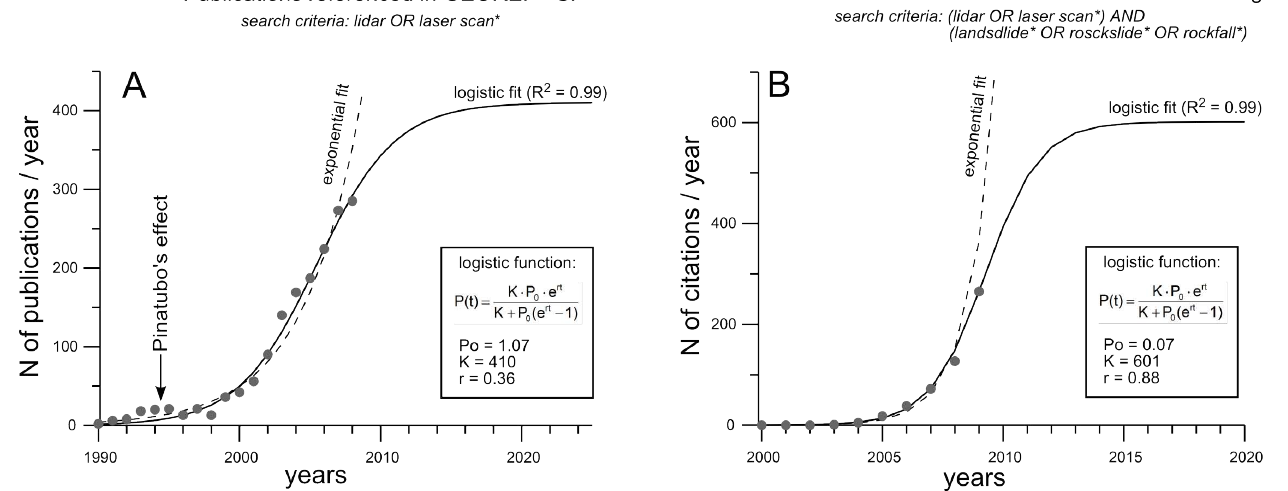
Fig. 1. (A) Number of publications per year (dots) registered in GEOREF that are related to LIDAR or laser scanning. The line is the best fit logistic function of the dots, with t =0 in 1990. The small increase of papers published in the mid 90’s is due to the use of LIDAR to study aerosols from the 1991 Pinatubo’s explosion. (B) Number of citations per year (dots) registered in ISI Web of knowledge that are related to LIDAR AND landslide. The line is the best fit logistic function of the dots, with t =0 in 2000. Po is the annual number of publications or citations at time t =0, K is the upper limit of the number of publications or citations per year and r is the growth